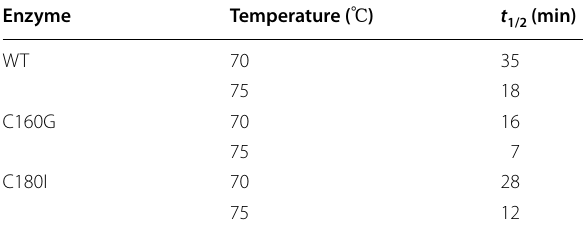
) of WT and its two mutants 1/2